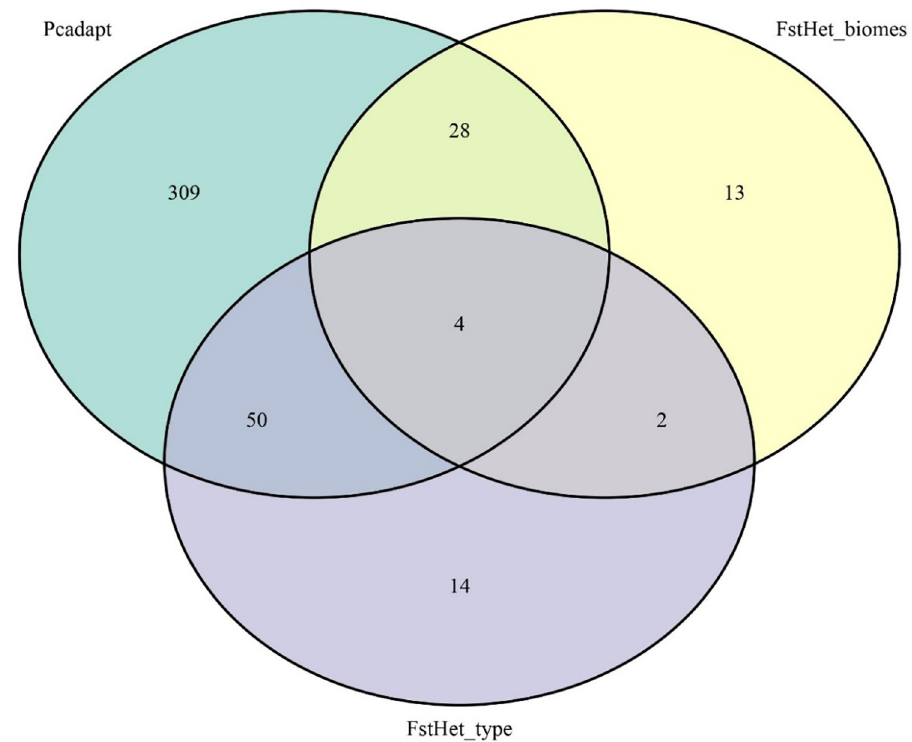
Fig 3. Venn diagram with the number of outlier loci detected for the fsthet and Pcadapt tests with the overlap between them.